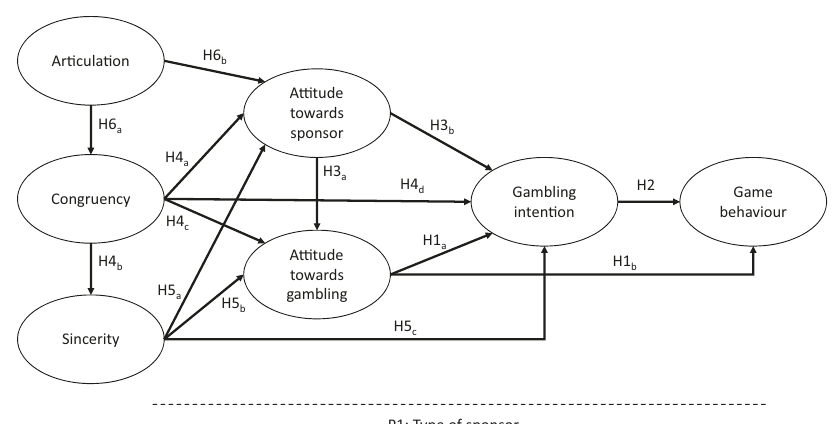
Fig. 1 Relationships and hypotheses of the theoretical model. Note: The dashed line represents the moderating effect of sponsor